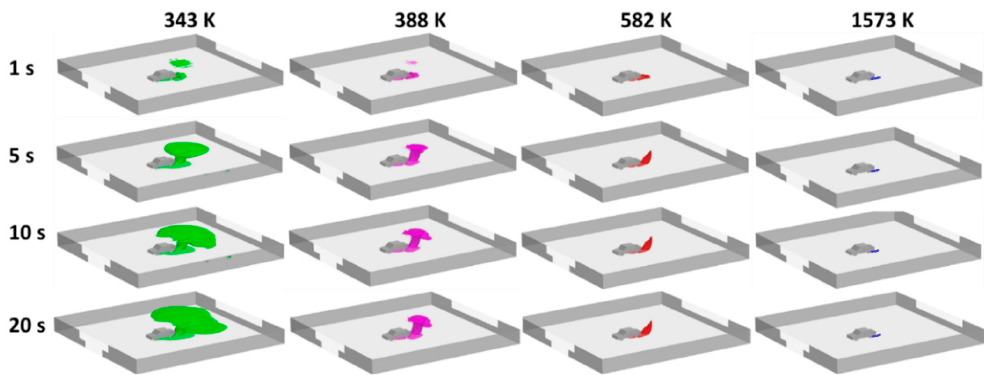
Figure 15. Iso-surfaces showing no-harm (343 K), pain (388 K), fatality (582 K) temperature limits and visible flame temperature (1573 K) for ignited hydrogen release in case 5 (TPRD = 0.5 mm, 30° angle downward release with tank blowdown and car body).